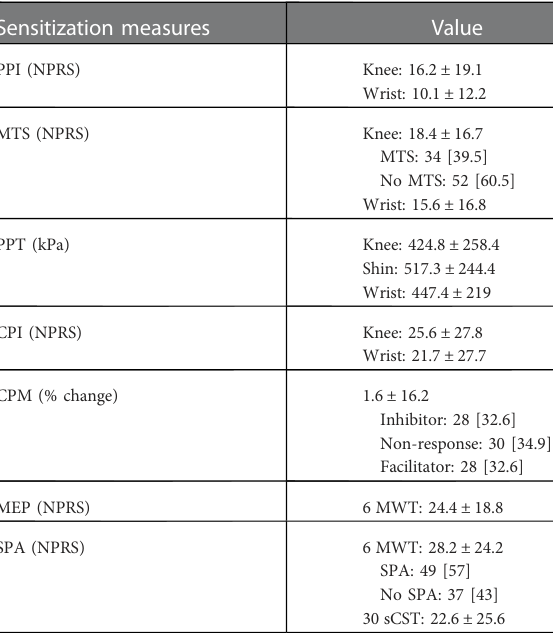
TABLE 4 Unadjusted univariable regression and correlation outcomes between measures of sensitization and knee OA outcomes at baseline Outcome variable Predictor